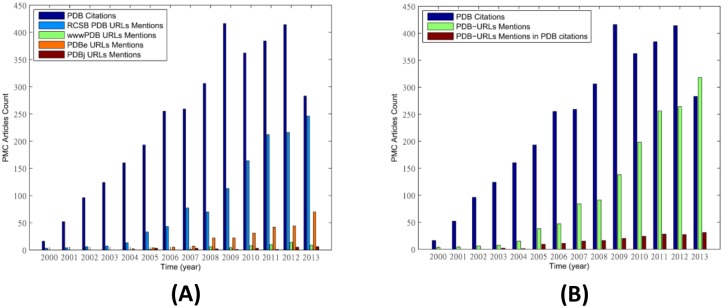
(A) Annual growth of the citations to the PDB debut paper and the counts of the different PDB URL mentions. (B) Annual growth of the citations to the PDB debut paper (blue bar), sum of all PDB URL mentions (green bar) and the count of the articles that not only directly cite the PDB debut paper but also mention PDB URLs (red bar).